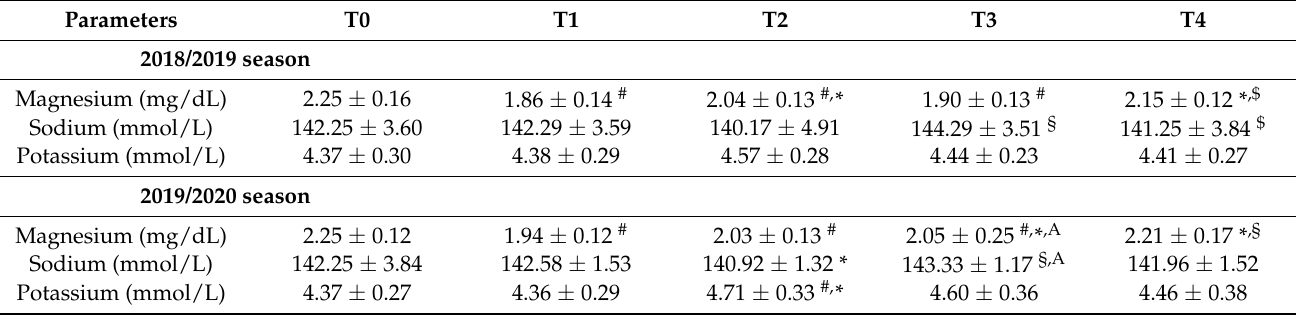
# Statistical difference from T0. * Statistical difference from T1. § Statistical difference from T2. $ Statistical difference from T3. A Statistical difference from 2018/2019